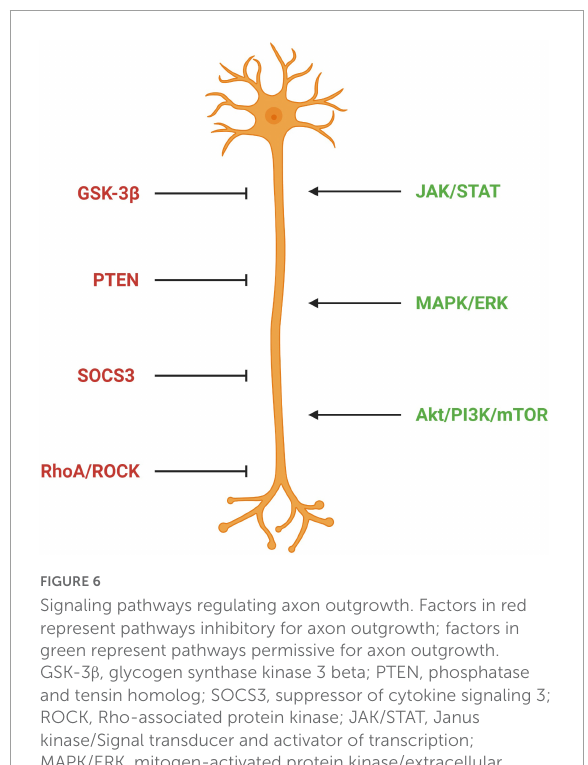
FIGURE6 Signaling pathways regulating axon outgrowth. Factors in red represent pathways inhibitory for axon outgrowth; factors in green represent pathways permissive for axon outgrowth. GSK-3 β , glycogen synthase kinase 3 beta; PTEN, phosphatase and tensin homolog; SOCS3, suppressor of cytokine signaling 3; ROCK, Rho-associated protein kinase; JAK/STAT, Janus kinase/Signal transducer and activator of transcription; MAPK/ERK, mitogen-activated protein kinase/extracellular signal-regulated kinase 1/2; Akt/PI2K/mTOR, protein kinase B/phosphatidylinositol-3-kinase/mammalian target of